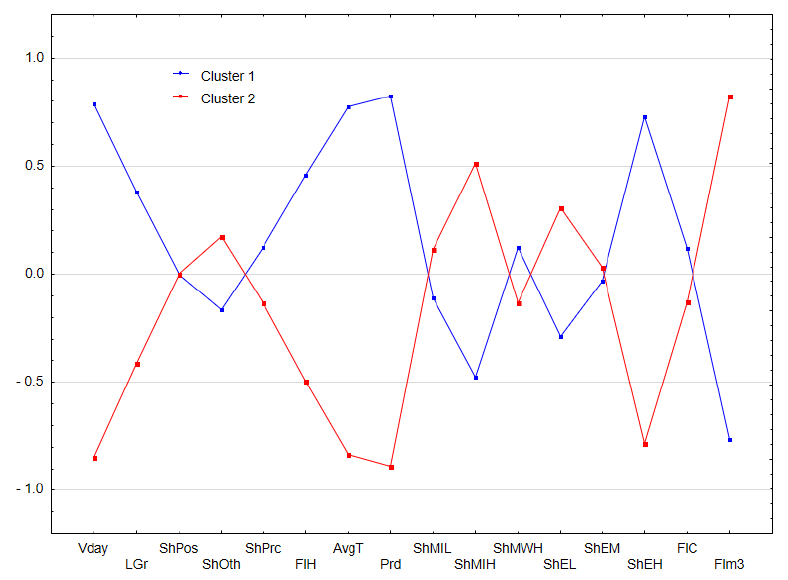
Figure 4. K-means separation of observations (workdays) into clusters and influence of variables—for both machines.